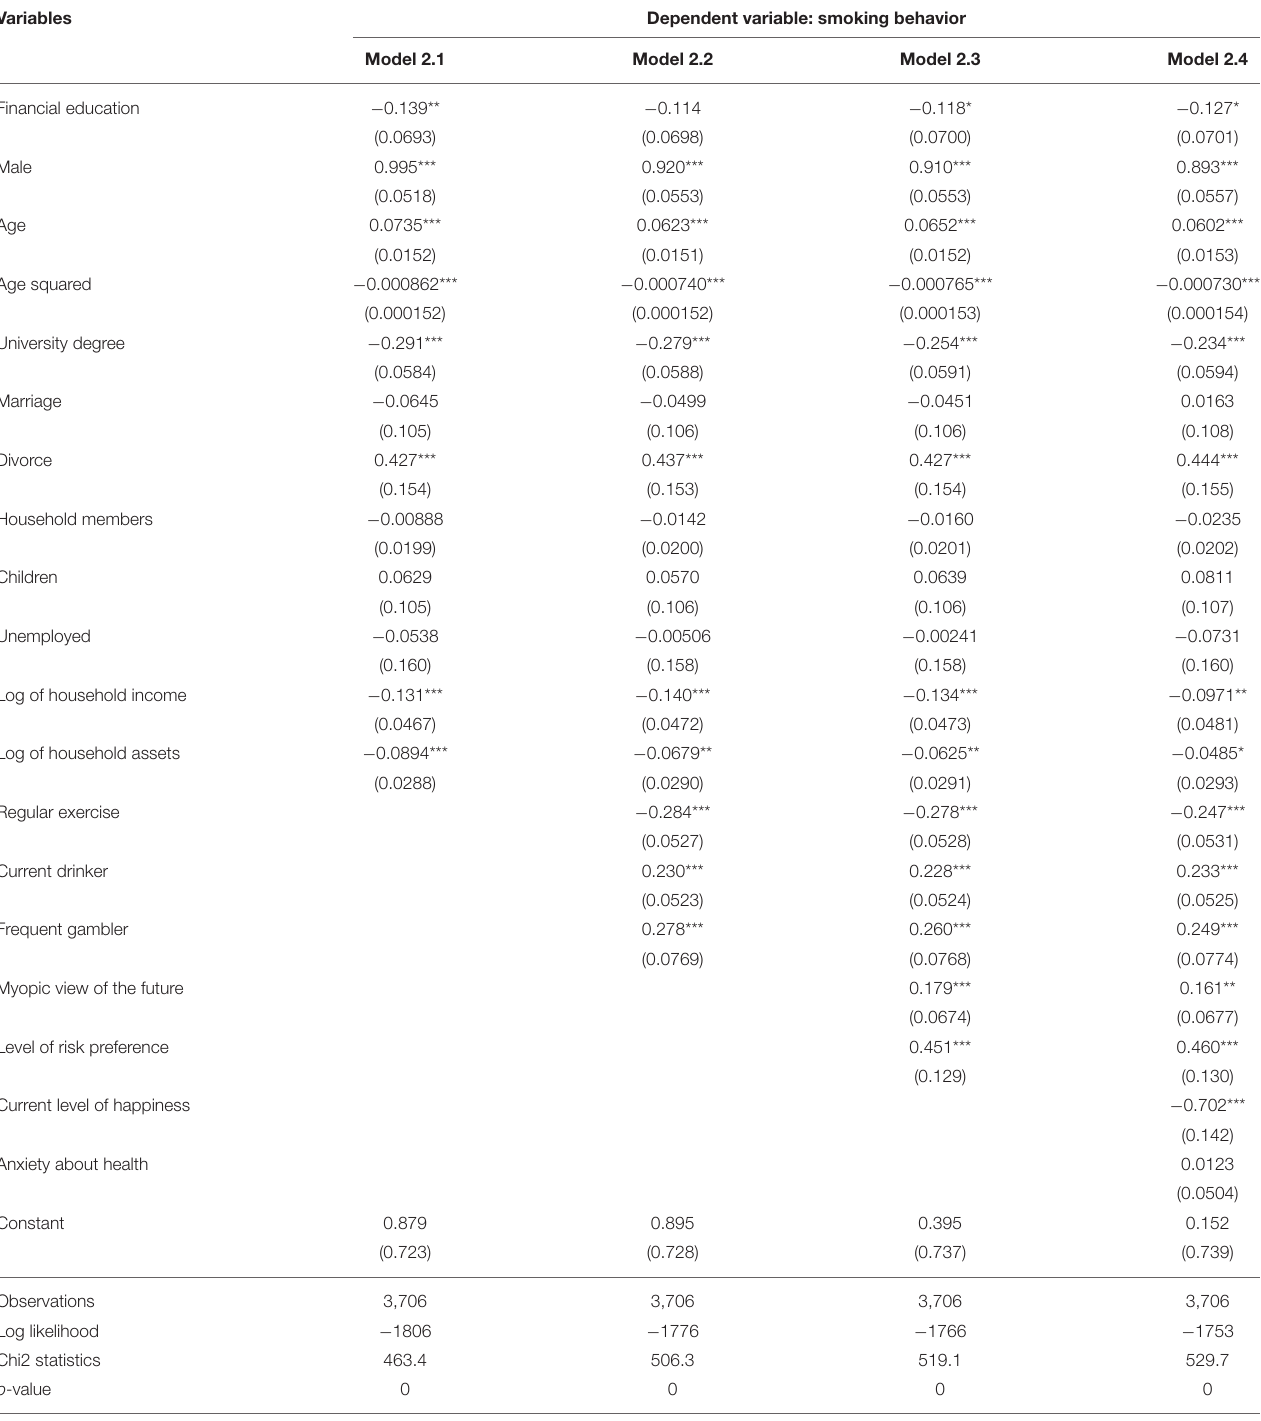
TABLE 7 | Probit model regression results, financial education as the main explanatory